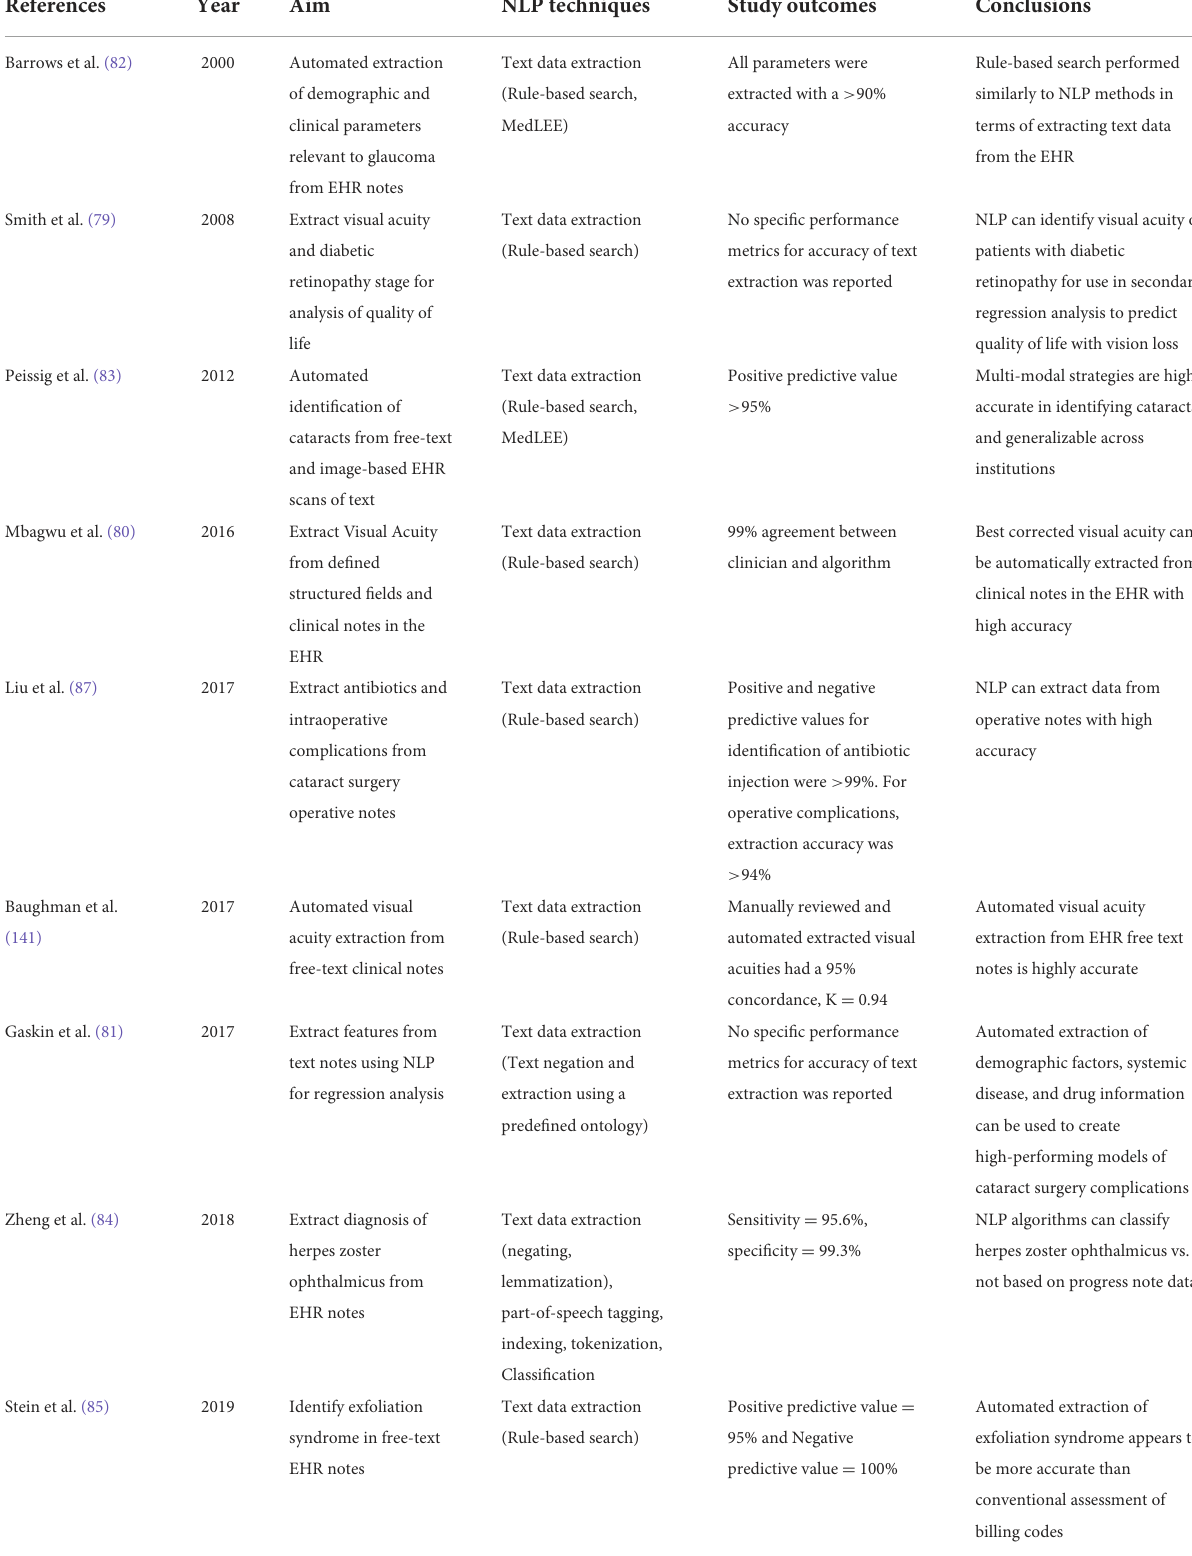
TABLE 1 Summary of Current Studies using NLP in